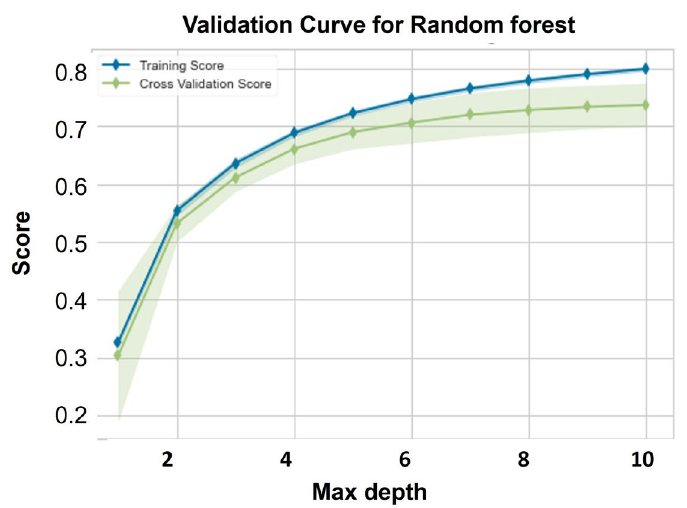
Figure 2. The internal model validation curve of RF model for the training score and the cross-validation score. x-axis represents the hyperparameter of the tress depth, y-axis represents the score (accuracy) of the model.